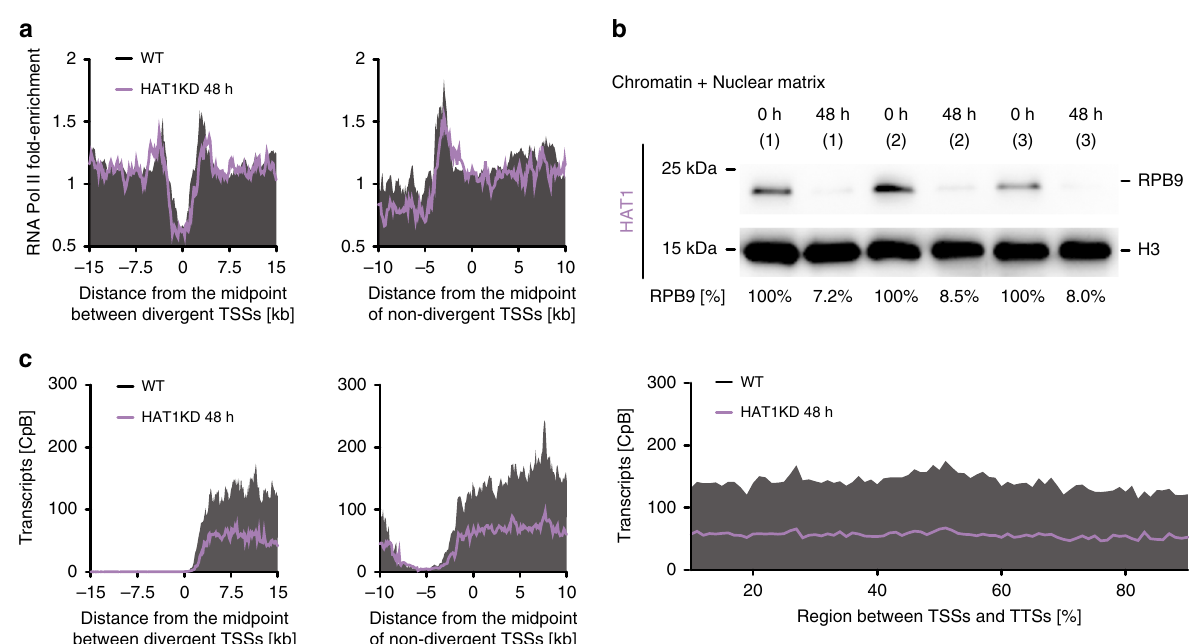
Fig. 8 Depletion of HAT1 affects mRNA transcript levels. a ChIP-seq data of RNA Pol II before (black) and after 48 h HAT1 depletion (purple) are averaged across divergent TSSs ( n = 37; left panel) and non-divergent TSSs ( n = 49; right panel). The ChIP-seq data are normalized to input data. Data from replicate 1 are shown, for all replicates see Supplementary Fig. 15. b Western blot of chromatin-associated proteins extracted from 2T1 cells, expressing TY1-tagged RPB9, before and after depletion of HAT1 ( n = 3) for 48 h. Loaded are the insoluble fractions, containing chromatin-bound and nuclear matrix material. RPB9 [%] refers to the relative TY1-RPB9/H3 ratio. The ratio at 0 h HAT1-depletion was set to 100%. The TY1-RPB9/H3 ratios were calculated by quantifying the TY1-RPB9 and H3 signal over the background for each lane signal using ImageJ (Supplementary Data 4). c RNA-seq data showing transcripts derived from the + strand before (black) and after 48 h HAT1 depletion (purple) are averaged across divergent TSSs ( n = 37; left panel), non-divergent TSSs ( n = 49; right panel) and across regions between TSSs and TTSs on the + strand ( n = 109; lower panel). The data are normalized to a spike-in control to account for differences in total RNA levels per cell after HAT1 depletion and plotted as counts per billion reads [CpB]. Shown is the average from three RNA-seq experiments (for normalization factors see Supplementary Data 5). Source data are provided as a Source Data fi